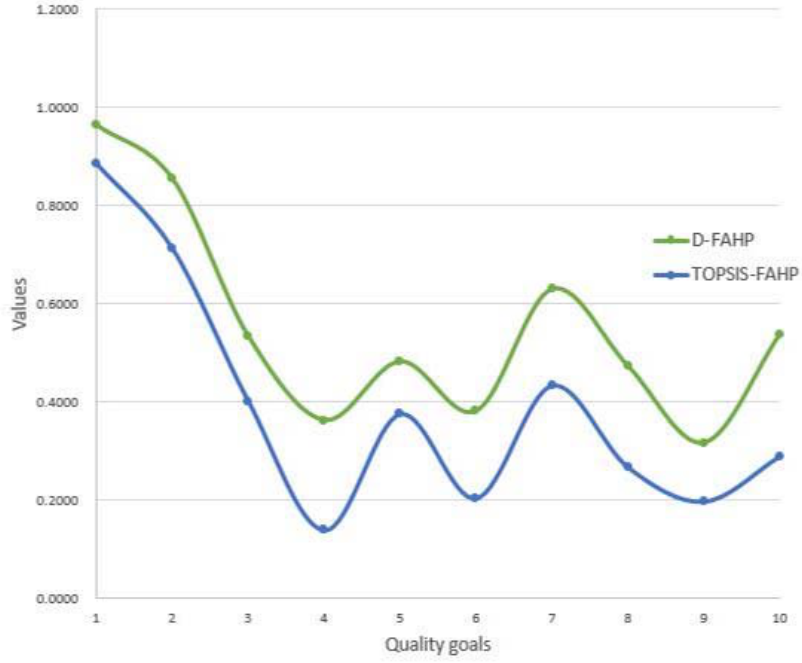
Figure 4. The compared analysis between D-FAHP and TOPSIS-FAHP